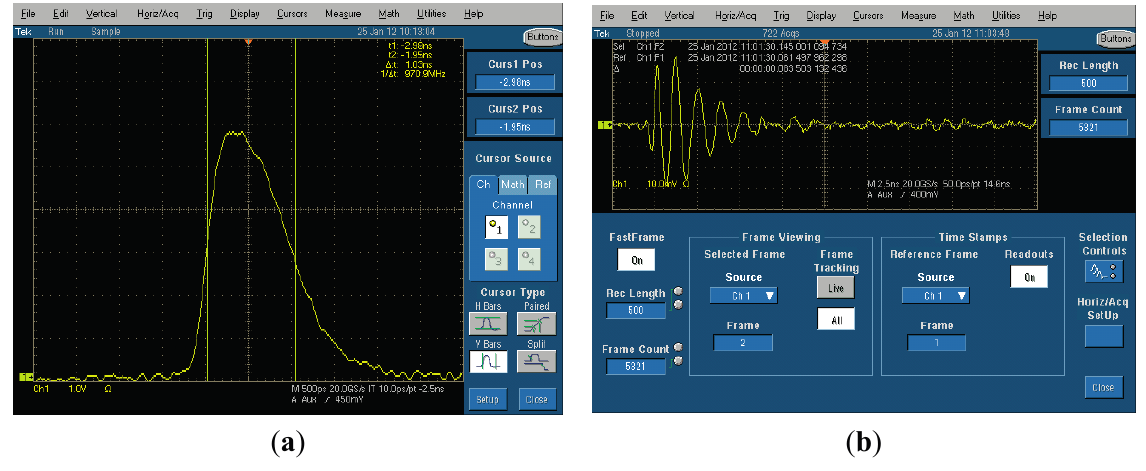
Figure 18. Example of ( a ) transmitted and ( b ) received waveforms in the experimental setup.